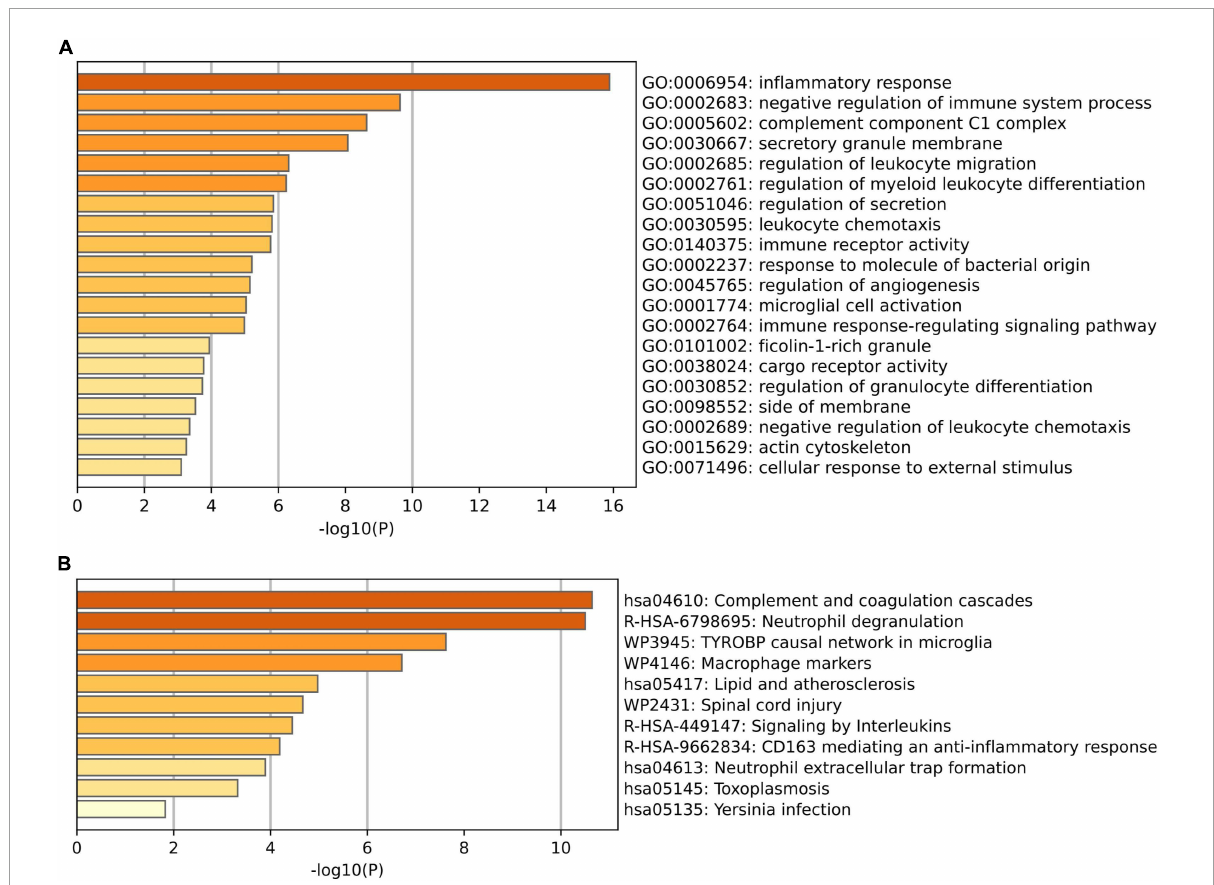
FIGURE3 Functional enrichment analysis of the overlapped differentially expressed genes (DEGs) between VaD and carotid atherosclerotic plaques datasets. (A) Significant enriched GO terms of the overlapped DEGs. (B) Significantly enriched pathways of the overlapped DEGs.